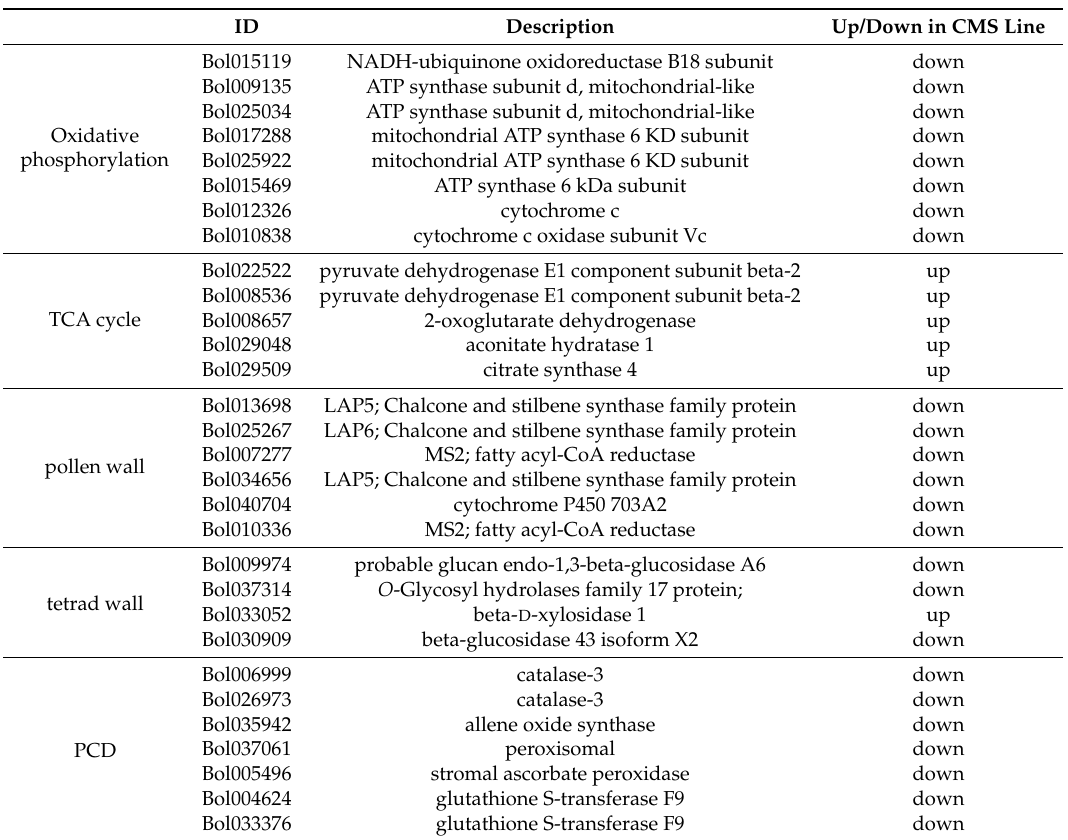
Table 1. Differential abundance protein species involved in oxidative phosphorylation, the tricarboxylic acid cycle, pollen wall, tetrad wall and programmed cell